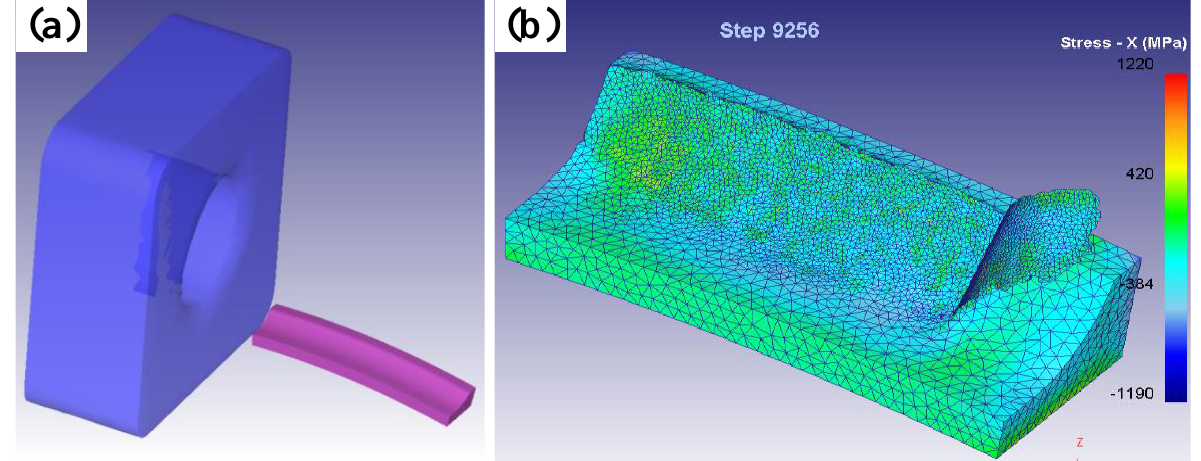
Figure 2. ( a ) Model of tool and workpiece and ( b ) residual stress distribution.